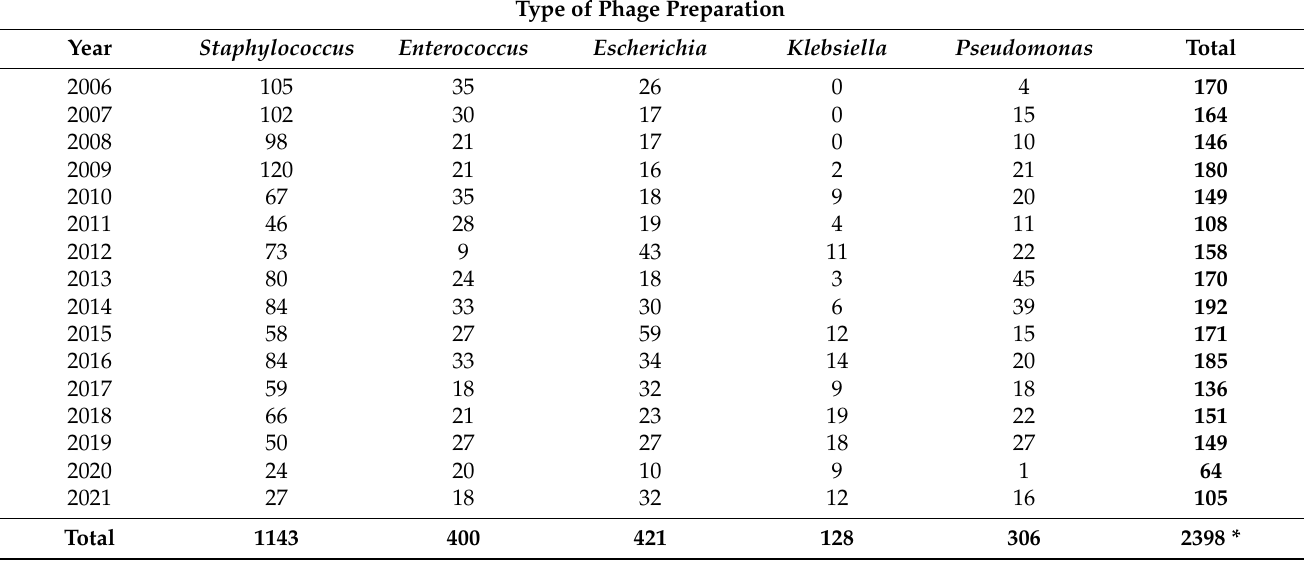
* One pack contains 33 vials of 10 mL